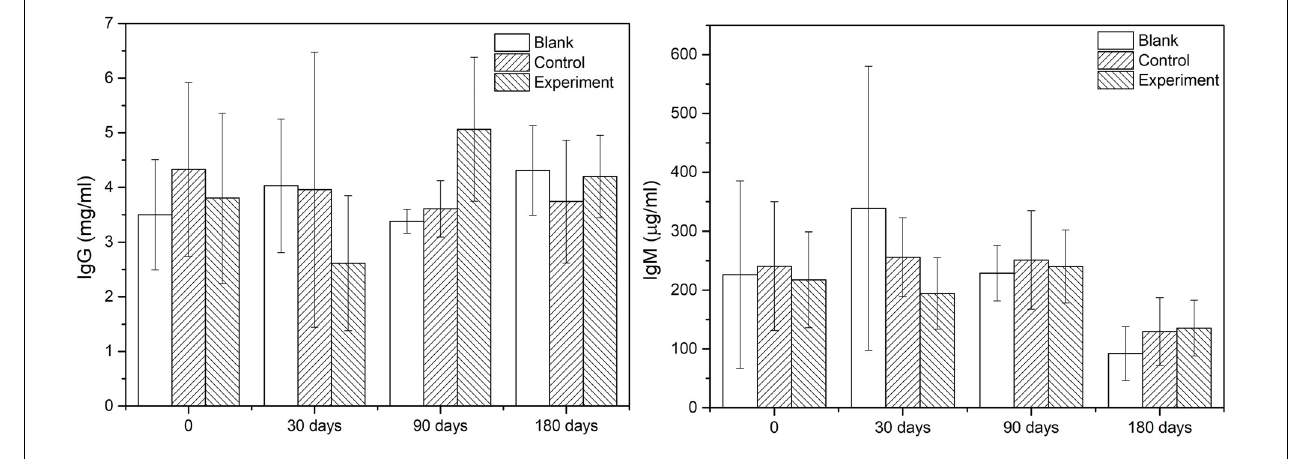
FIGURE 5 | The IgG and IgM contents in serum.